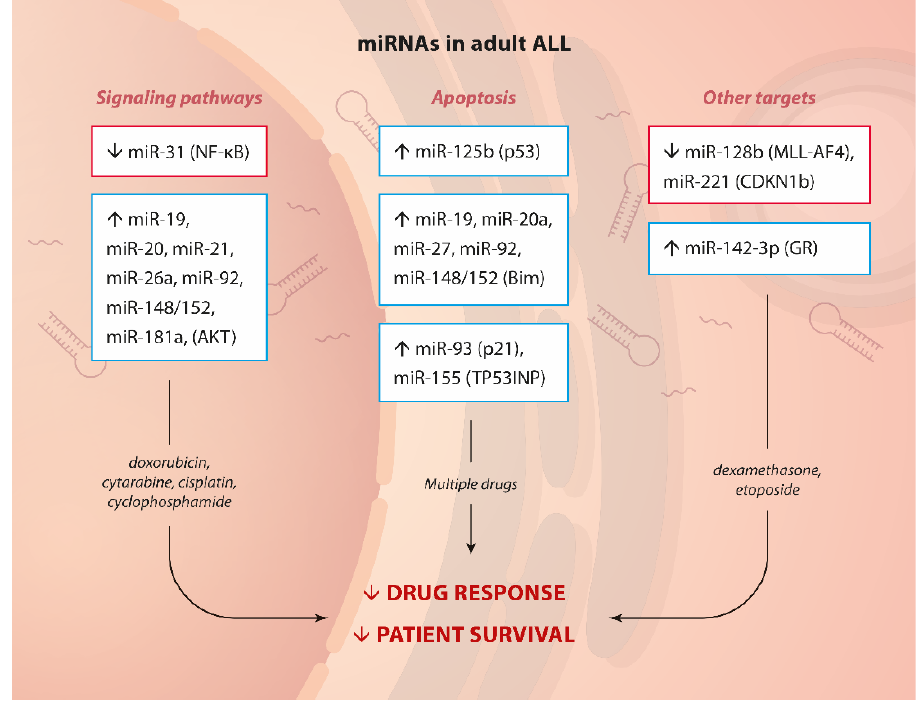
Figure 1. miRNA and drug resistance in adult ALL.Summary of up- or down-regulated miRNAs, their targets or the pathways affected (in brackets) and involvement in drug resistance in adult ALL.